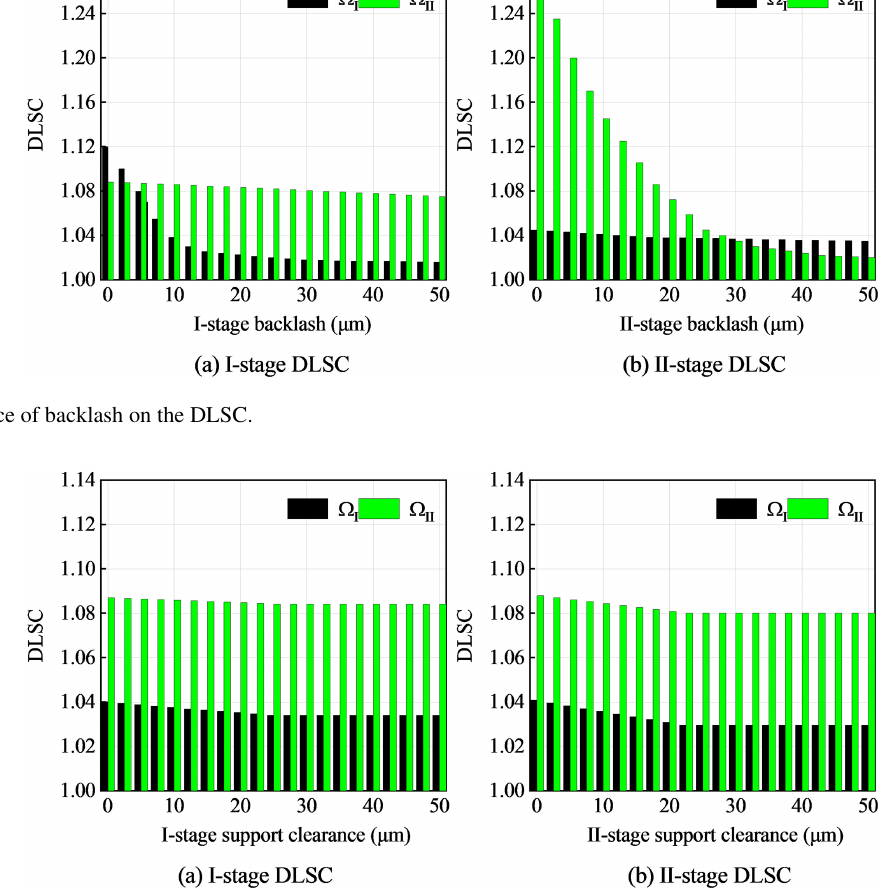
Figure 14. Influence of support clearance on the